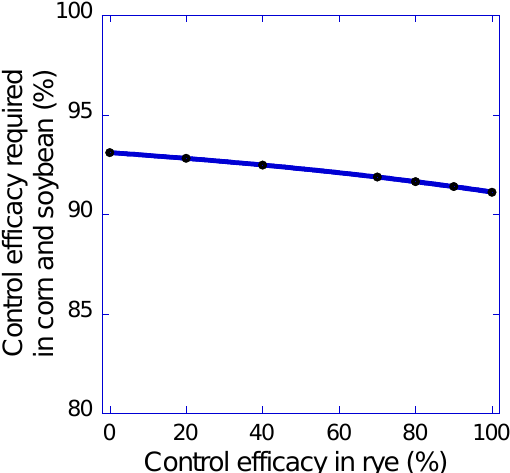
Figure 5. The relationship between weed control efficacy in the rye phase of the 5-year rotation and the minimum level of control efficacy required in corn and soybean to prevent increases in giant ragweed seed density.